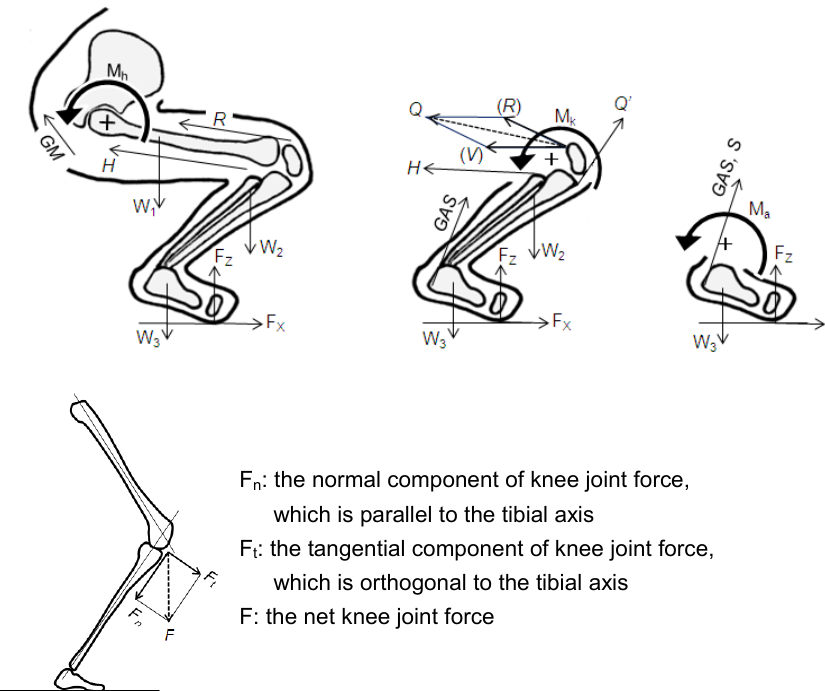
Fig.3 Two dimensional mathematical models for the moments around the hip (upper left), knee (upper center) and ankle (upper right) joints, and the relationship between the net knee joint force and their normal and tangential components (lower). The variables representing the tensile force generated by the muscles and tendons are H : hamstrings, GM : gluteus, R : rectus femoris, V : the vasti, Q : quadriceps (the vector sum of R and V ), Q' : patella tendon, GAS : gastrocnemius, S : soleus The variables representing the force acting on the knee joint as illustrated in Fig.3 (defined as the force acting on the tibia from the femur) are